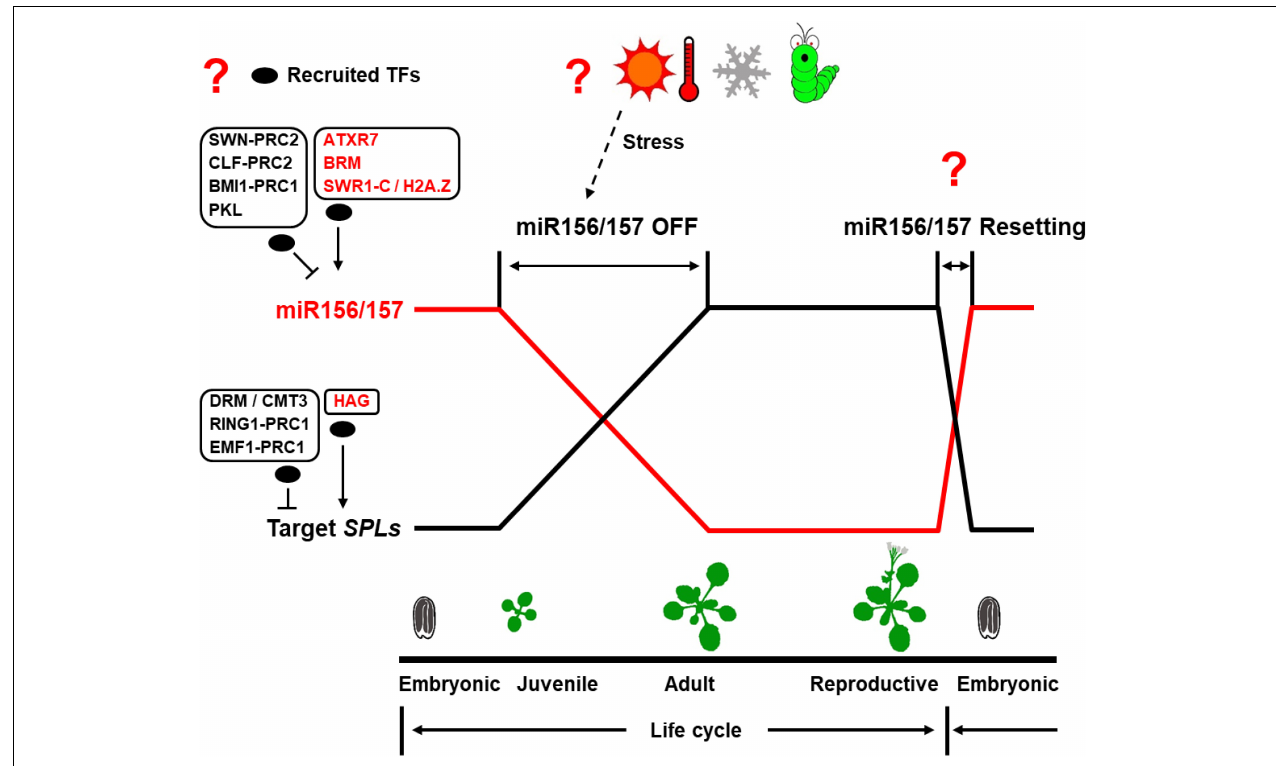
FIGURE 2 | Epigenetic regulation of the miR156/157-SPL pathway in plant lifecycle. In plant lifecycle, the transcription of genes in the miR156/157-SPL pathway exhibits a fixed temporal expression pattern. The major unknown parts in epigenetic regulation of the miR156/157-SPL pathway are shown in question mark. Oval represents recruited transcription factors